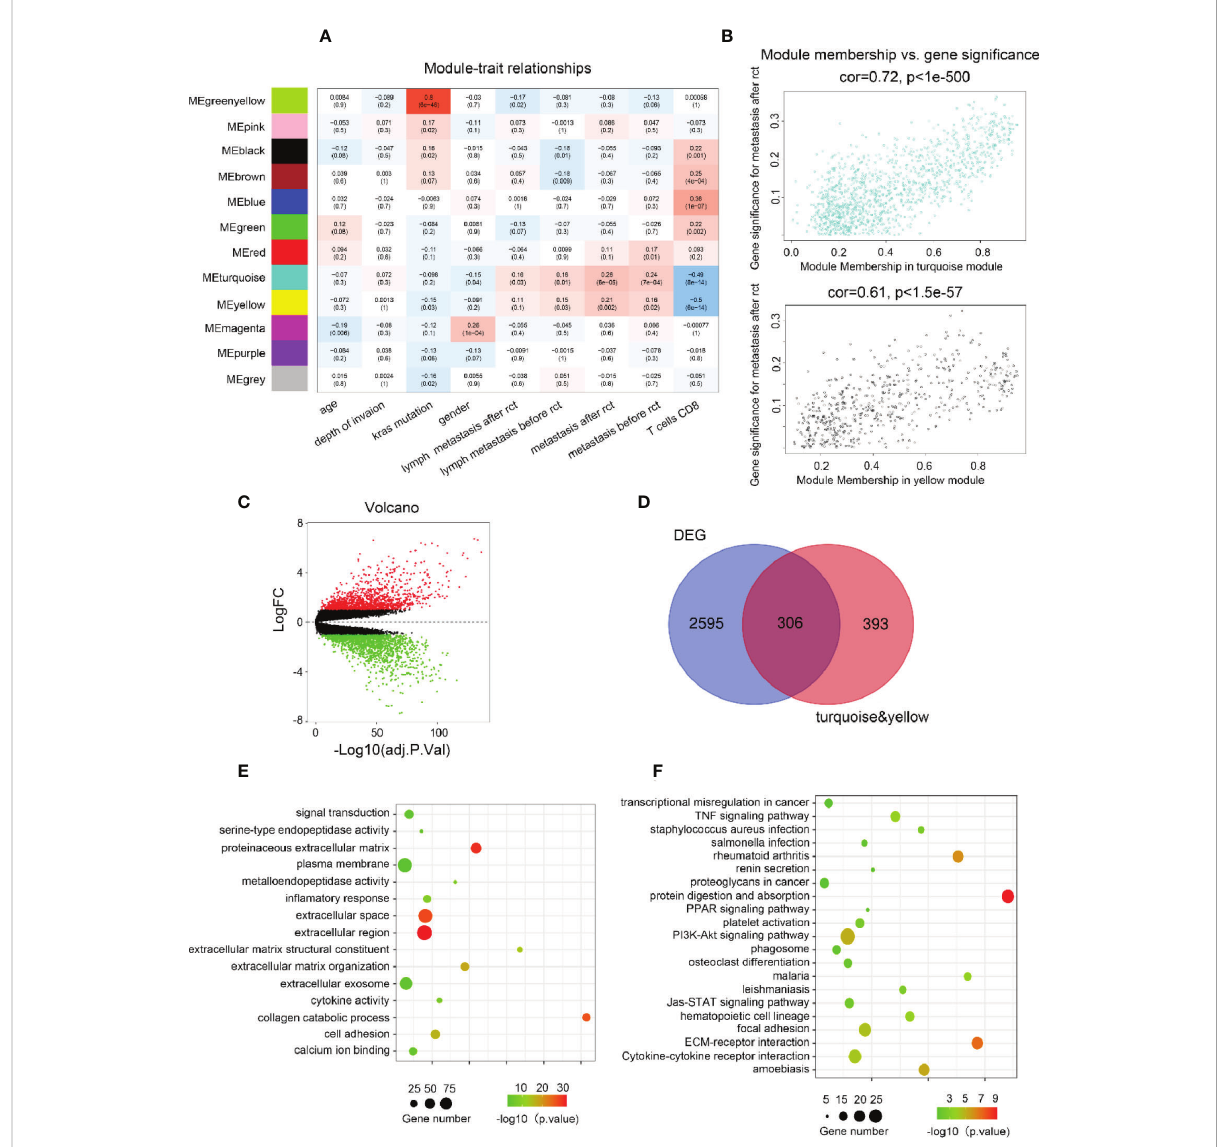
FIGURE 1 Biological function and pathway annotation. (A) Heatmap of the correlation between modules and cancer hallmarks. (B) Correlation between turquoise/yellow module and metastasis. (C) The volcano plot of differentially expressed genes (DEGs) between colorectal carcinoma samples and normal colorectal tissue samples (logFC > 2 and adjusted p-value <0.05). The horizontal axis represents the adjusted p-value, and the vertical axis represents the fold change. Red and green circles indicate up- and down-regulated genes, respectively. (D) Venn plot of the intersection of upregulated differentially expressed genes and selected genes from WGCNA. (E) The top 15 GO functions enriched for the upregulated 306 genes. (F) The top of 21 KEGG pathways enriched for the up-related 306